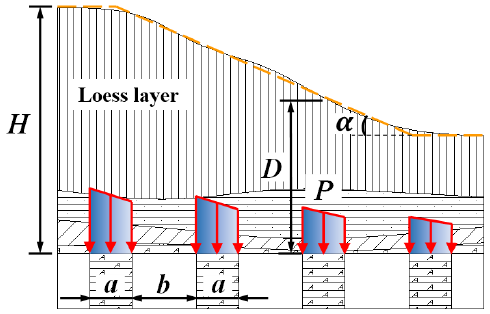
Figure 2. Schematic diagram of goaf space structure and pillar load.